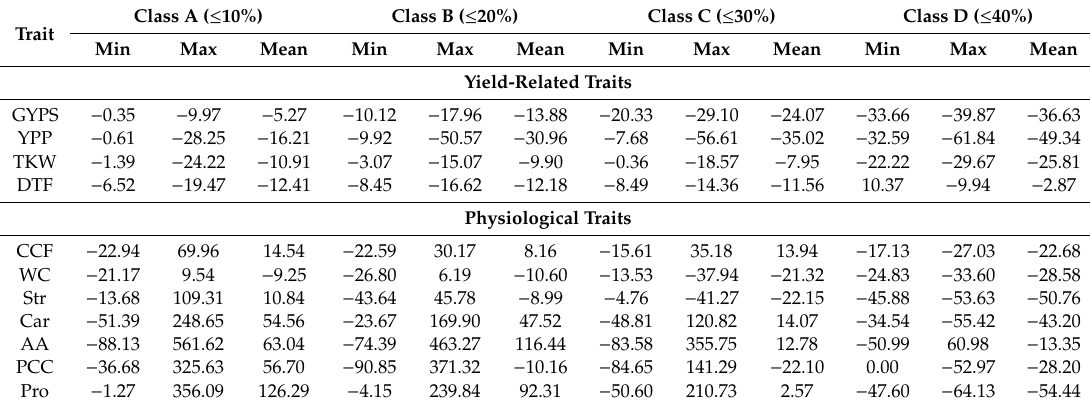
Table 3. Ranges of the percentage changes in all traits of control and heat stressed plants in the four classes, A, B, C, and D.